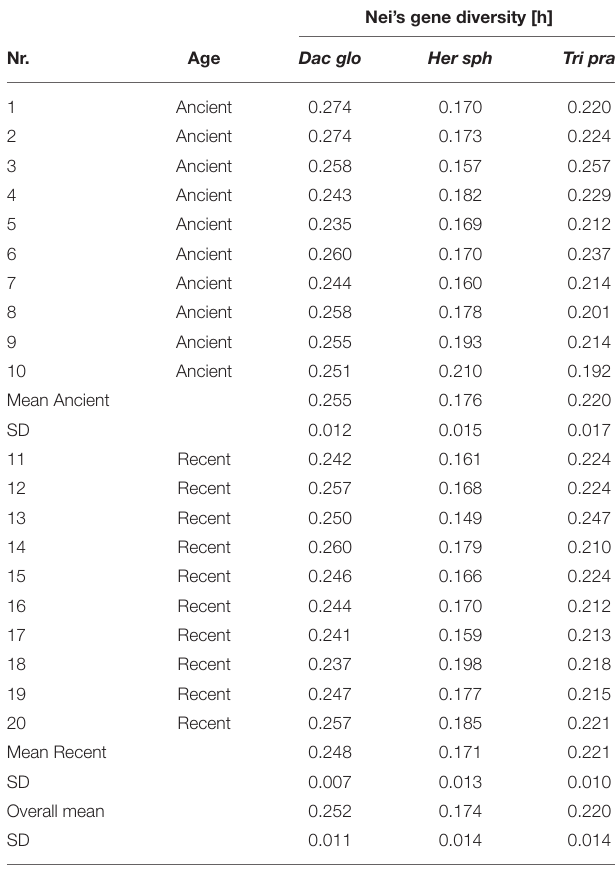
TABLE 2 | Genetic diversity of all three species given as Nei’s gene